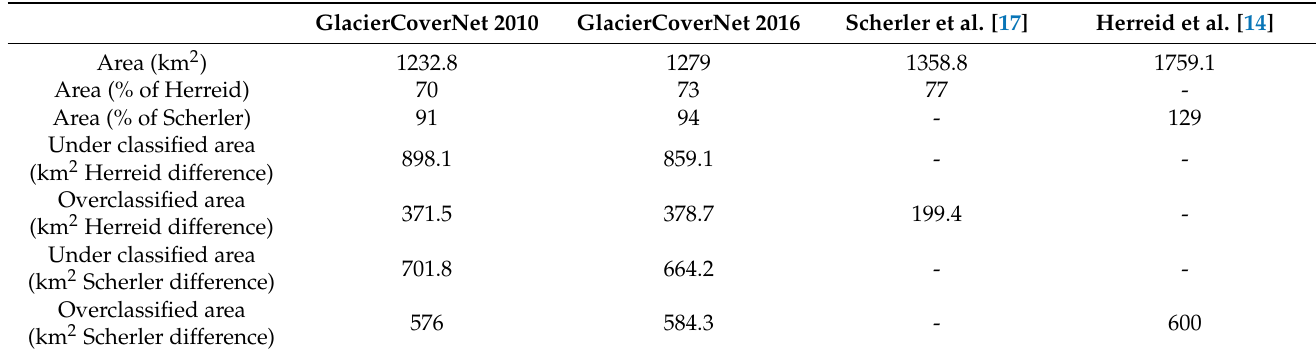
Table 5. Summary of area of supraglacial debris captured by GlacierCoverNet for 2010 and 2016. GlacierCoverNet